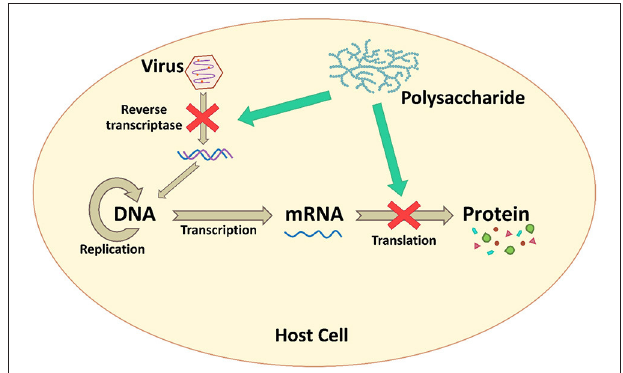
FIGURE 4 | The inhibition mechanism by interfering with viral genome replication and protein